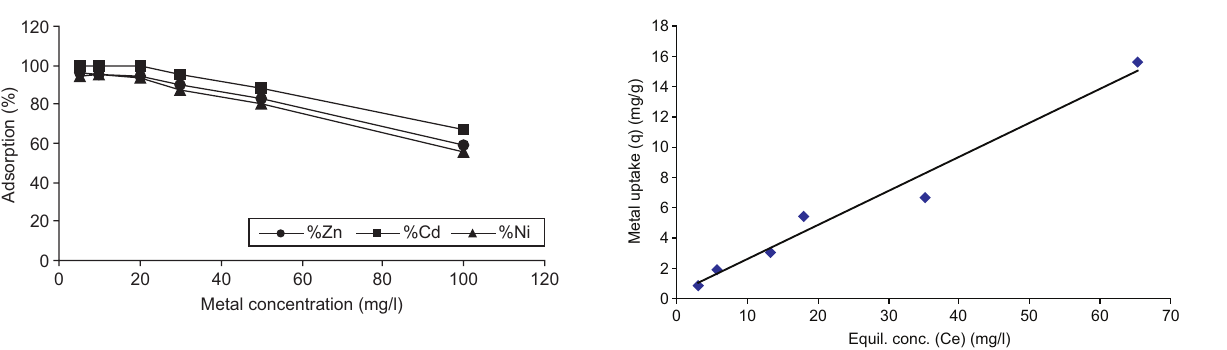
Figure 4 The effect of initial metal concentration.